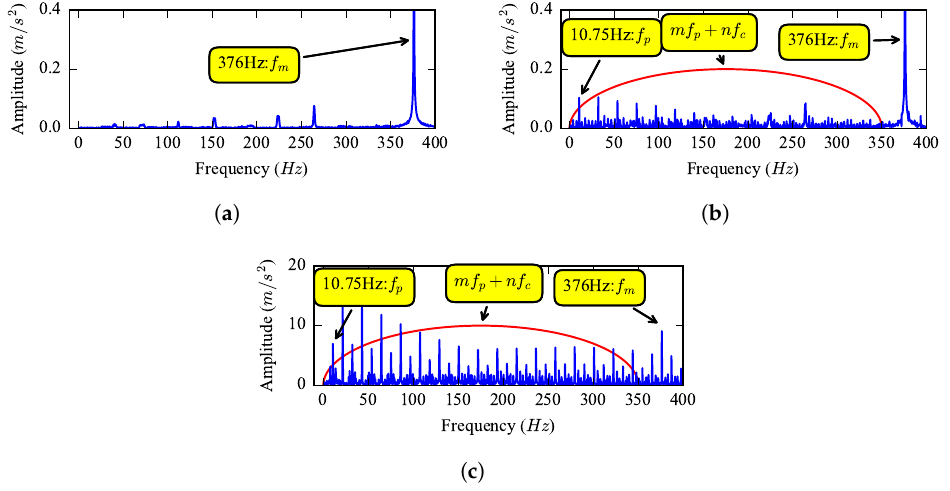
Figure 9. Envelope spectrum of the simulated ring acceleration of the ( a ) healthy gear p = 0, ( b ) half tooth breakage fault gear p = 0.2 and ( c ) the whole tooth breakage fault p =